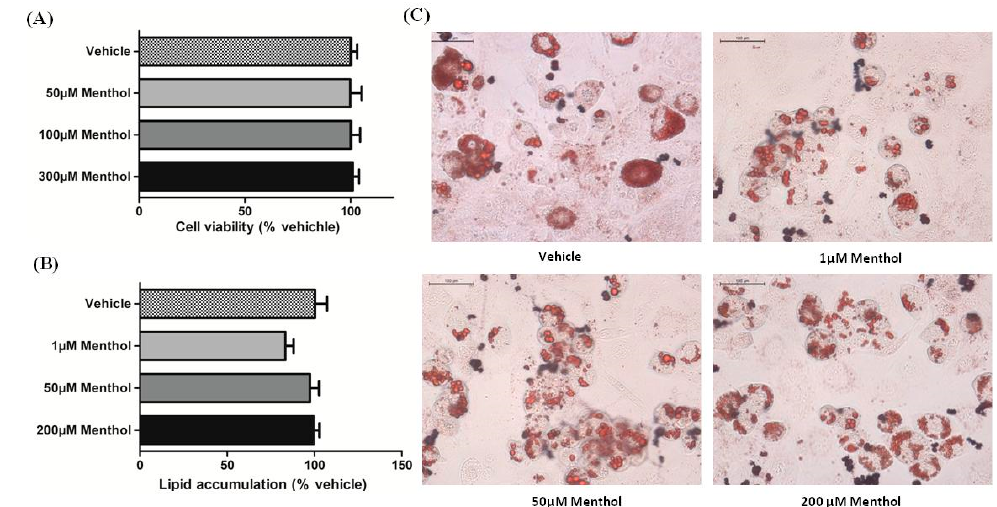
Figure 2. E ff ect of menthol on adipogenesis in 3T3-L1 cells. ( A ) Cell viability in pre-adipocytes treated with menthol for 24 h. ( B ) E ff ect of menthol on lipid accumulation in 3T3-L1 cells. ( C ) E ff ect of various concentration of menthol on di ff erentiation of 3T3-L1 cells. Red spots in images represents area stained by Oil Red O dye. All values are expressed as mean ± S.E.M. ( n = 3). One-way ANOVA followed by Tukey’s multiple comparison post hoc test was applied. * each vs. vehicle.